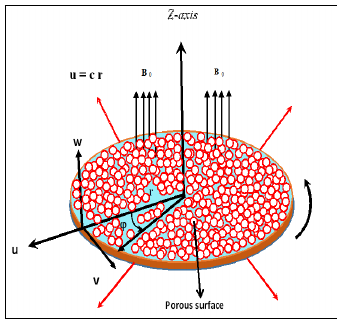
Figure 1. Flow diagram [13].